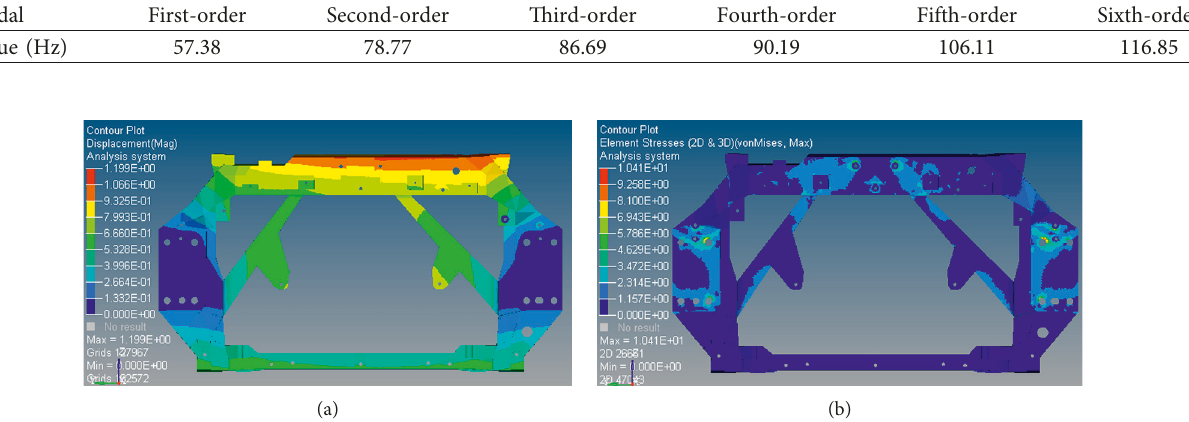
Figure 23: Results of the static analysis of the front-end frame. (a) Static analysis of displacement cloud map; and (b) statics analysis of stress cloud map.